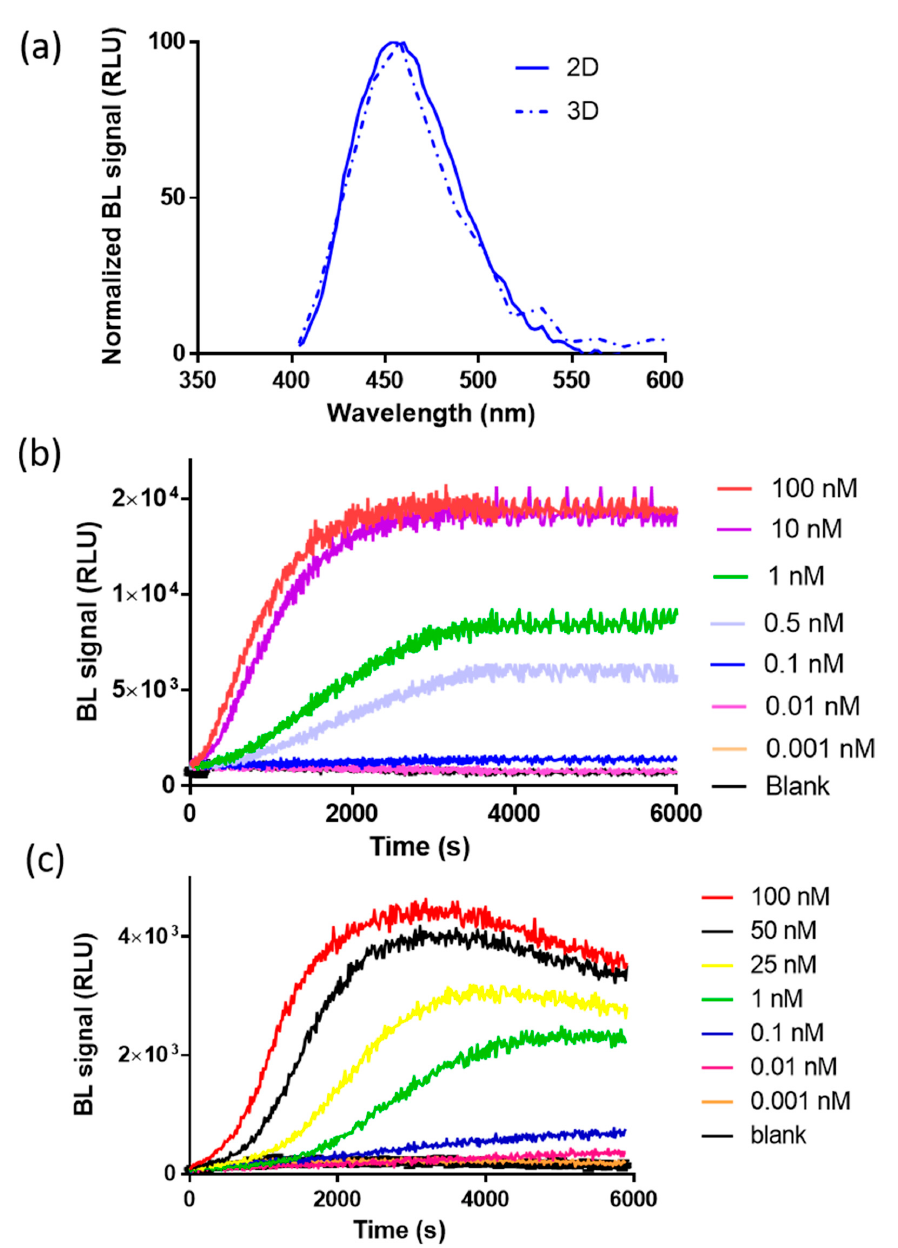
Figure 2. Characterization of the bioluminescence (BL) nanosensor signal in 2D and 3D cells. ( a ) Nor- malized emission spectra of reconstituted NanoBiT in spheroids (dotted line) and in 2D cell cultures (solid line) after the addition of 100 nM of testosterone (final concentration). Emission spectra were obtained in nonlysing conditions using the Nano-Glo ® Live Cell Assay System substrate; ( b ) emission kinetics of reconstituted NanoBiT in the 2D cell culture obtained in nonlysing condition after the addition of testosterone solutions (concentration range of 0.001–100 nM); ( c ) emission kinetics of reconstituted NanoBiT in HEK293 spheroids obtained in nonlysing condition after the addition of testosterone (concentration range of 0.001–100